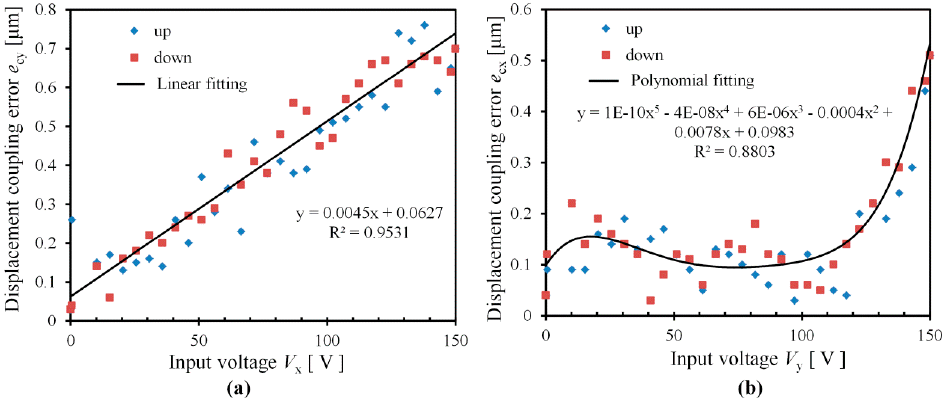
Figure 9. Displacement coupling errors: ( a ) coupling error for y -stage; ( b ) coupling error for x -tage.